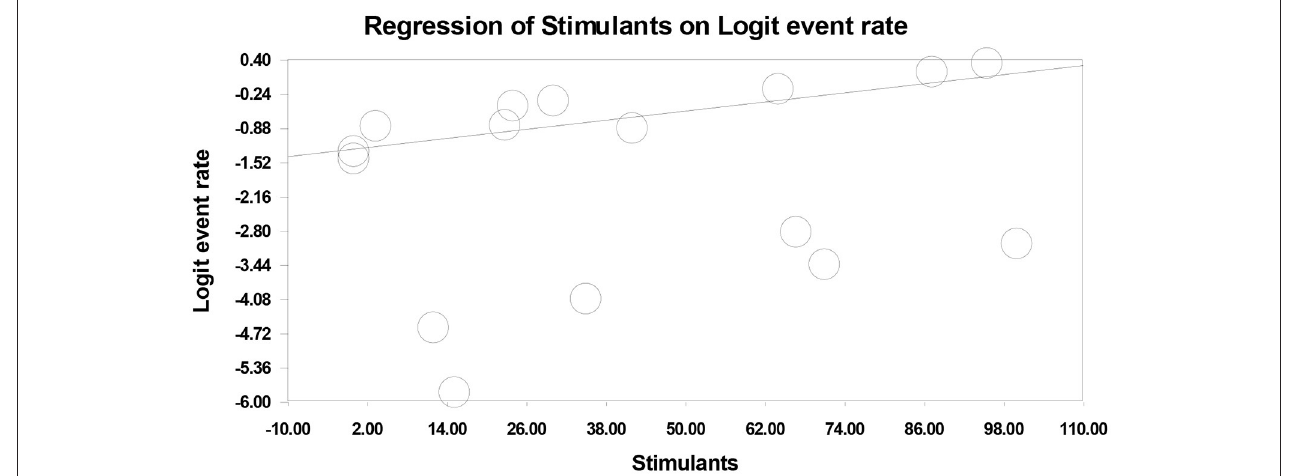
FIGURE 3 | The influence of percentage of patients with stimulant use disorder on drop-out rates across experimental